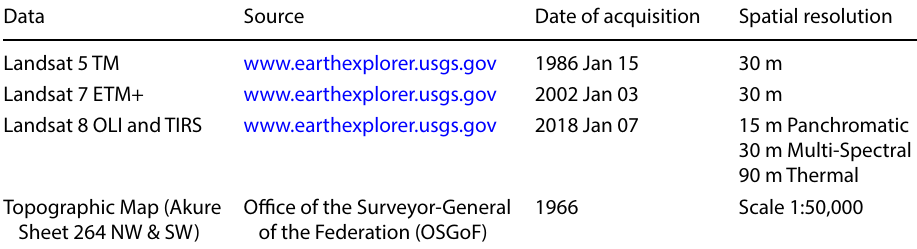
Table 1 Description of secondary data